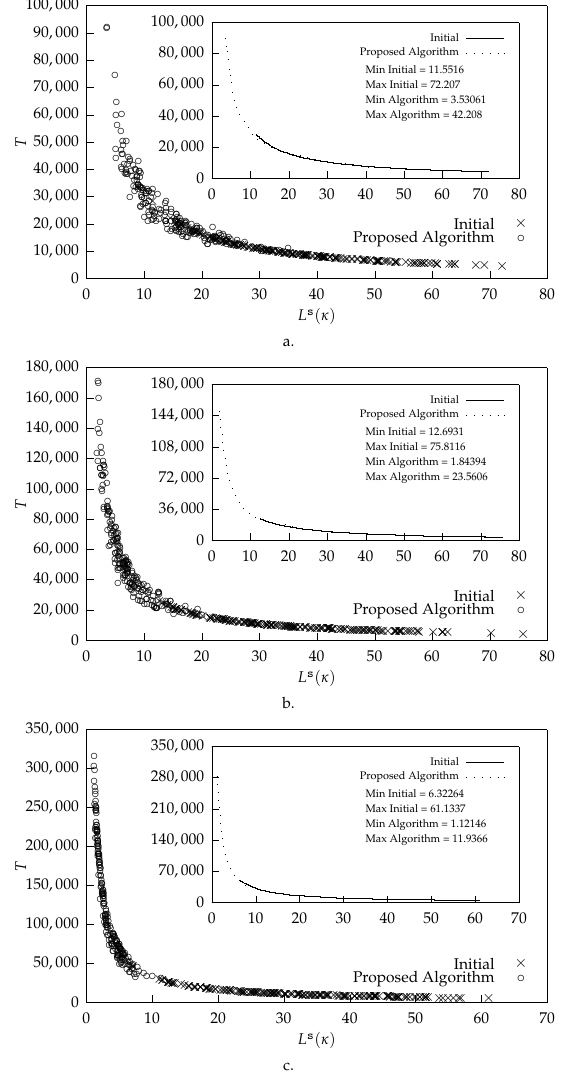
Figure 5. Termination time T against the cumulative traffic load of the most energy-consuming node L s ( κ ) before (initial) and after (proposed algorithm) applying the algorithm when each node plays the role of the sink node, for three different values of r c (( a ) r c = 0.3, ( b ) r c = 0.4, and ( c ) r c =